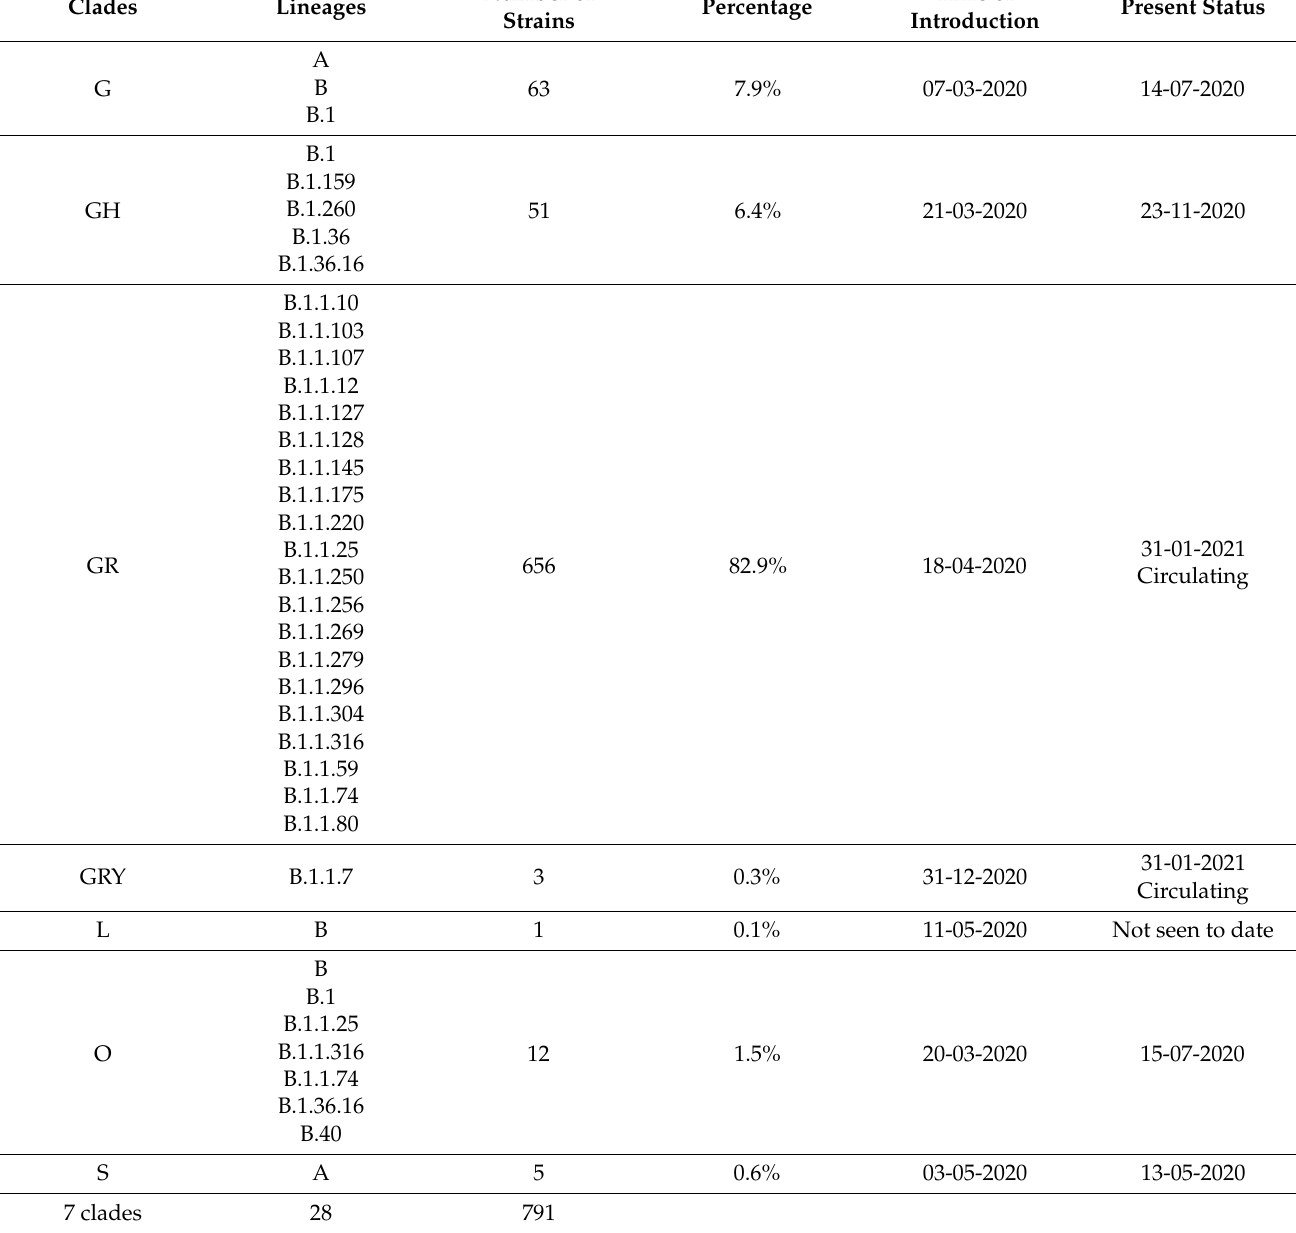
Table 1. Clade and lineage distribution of circulating strains of SARS-CoV-2 from Bangladesh. Clades Lineages